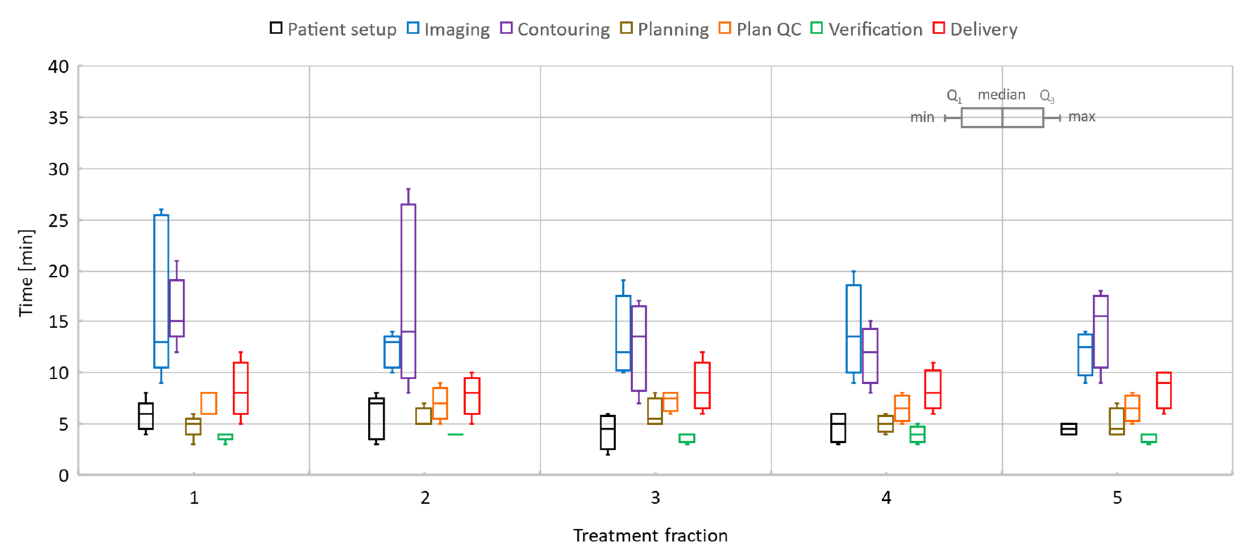
Figure 7. Liver online adaptive sessions for Fractions 1 and 5 and including the dry-run (or Day 0) session where available. The time required to perform key processes in the adapt-to-shape work- flow.